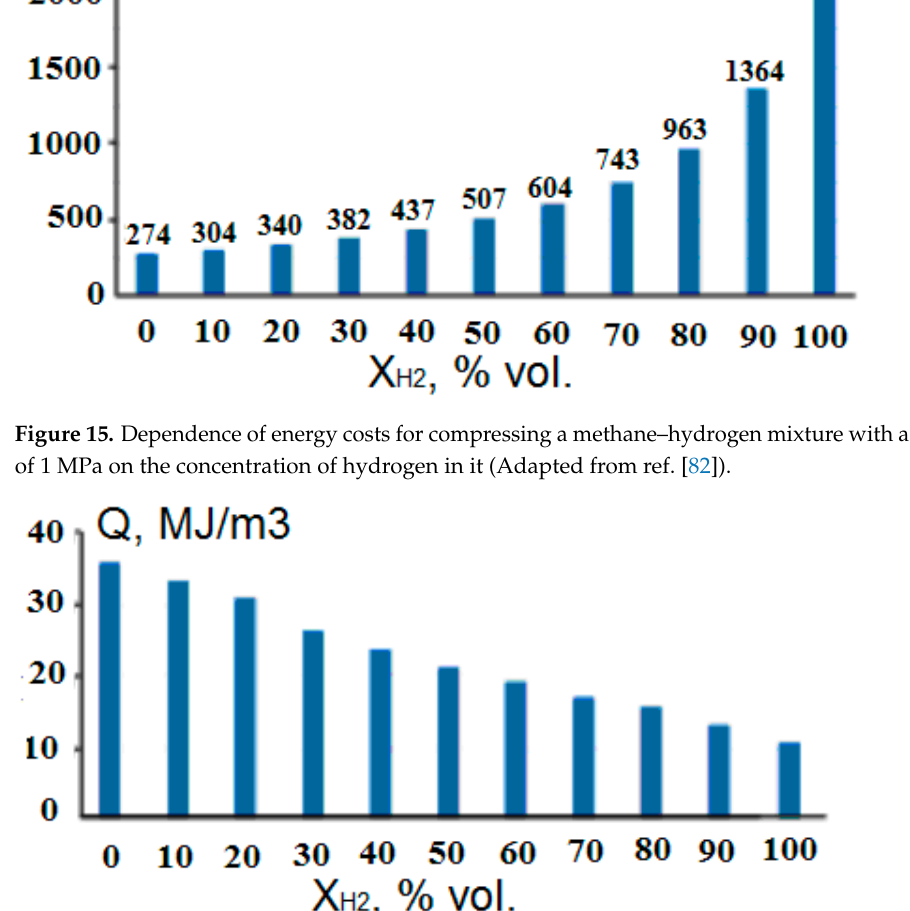
Figure 16. Dependence of the calorific value of methane–hydrogen mixtures on the concentration of hydrogen (Adapted from ref. [82]).